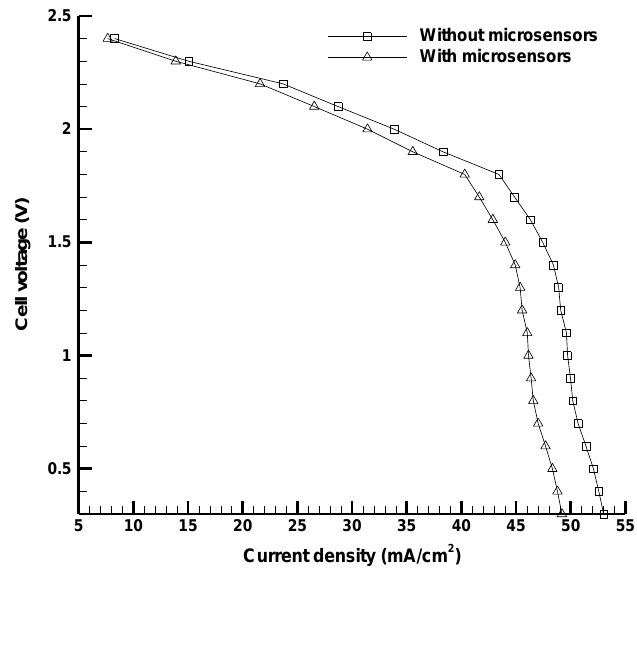
Figure 11. Fuel cell performance with and without